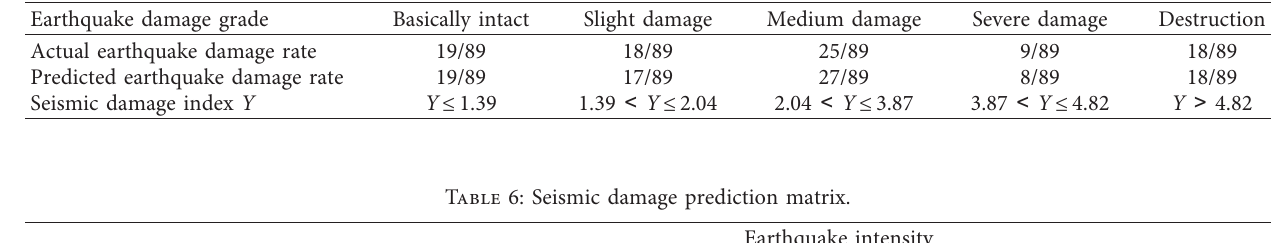
Table 5: Seismic damage index.